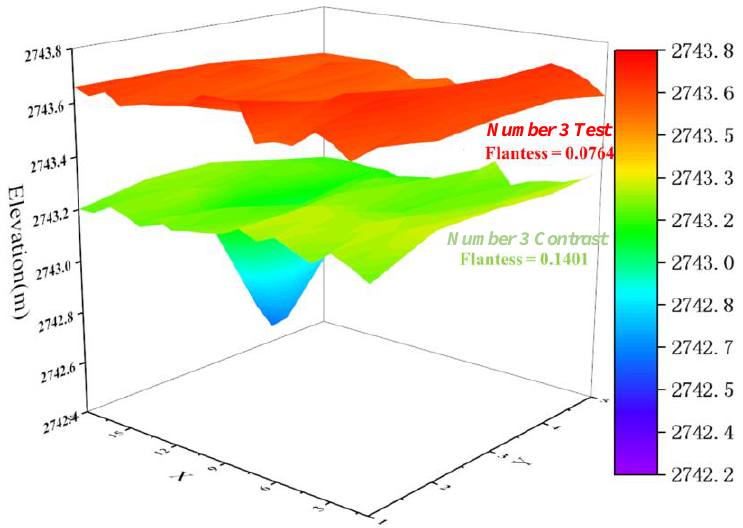
Figure 11. Three-dimensional surface colour map of the elevation at each position at the end of the paving of the two sets.